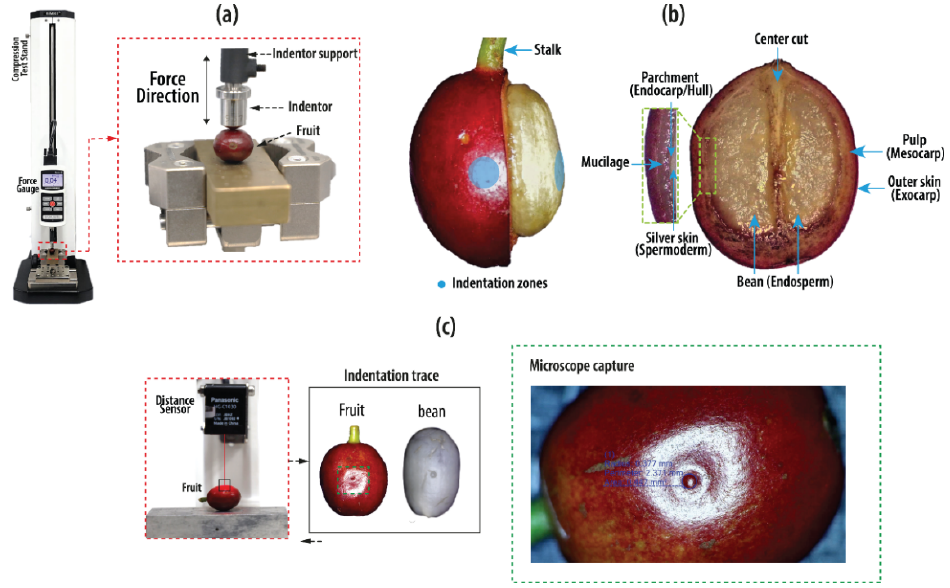
Figure 2. ( a ) Indentation test description. ( b ) Anatomy of the coffee fruit. ( c ) Indenter mark on the exocarp. Table 2. Parameters for calculation of elastic properties of Coffea arabica L. var. Castillo fruit and